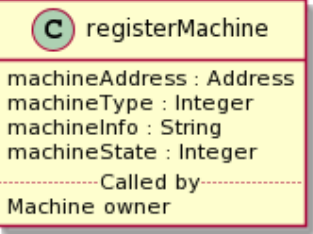
Figure 4. An example of a smart contract function and corresponding parameters.